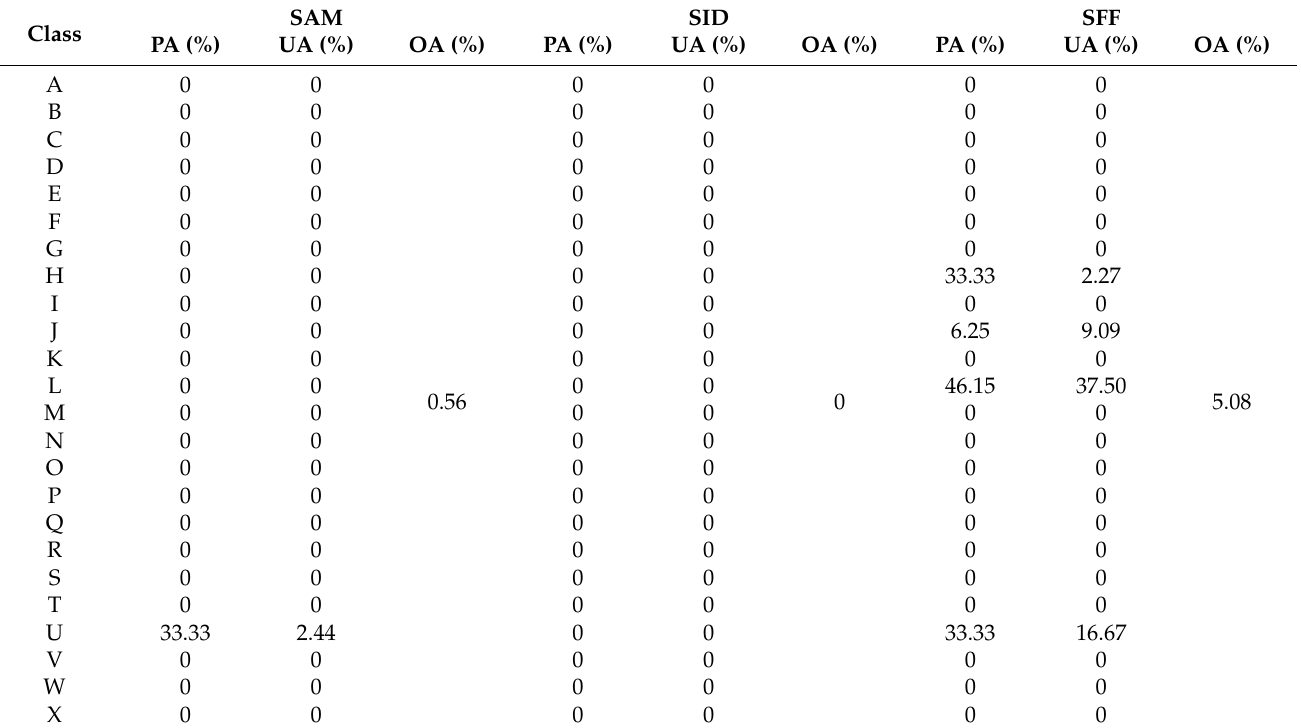
Table 5. Accuracy of mangrove species mapping with SAM, SID, and SFF-based classifications at Level